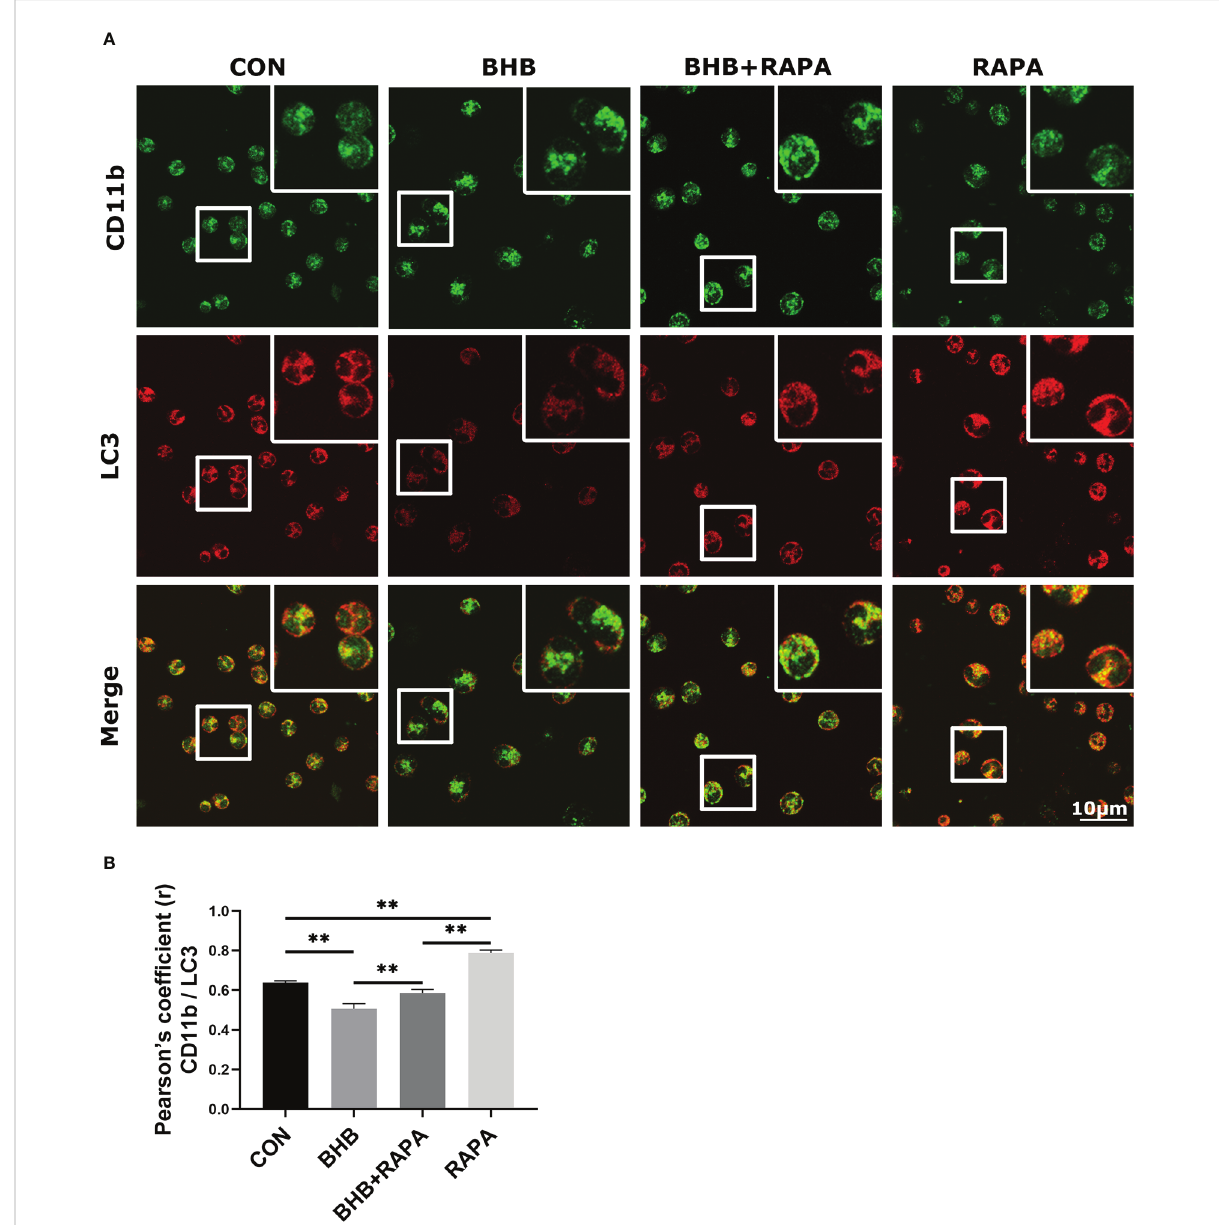
FIGURE 5 Role of autophagy in BHB induced depression of co-localization between CD11b and LC3. Rapamycin (100 n M , 2 h ) was used to activate autophagy. (A) Immuno fl uorescence data showed the co-localization of CD11b with LC3 in neutrophils. Magni fi cation 400×. Scale bar = 10 m m. Nuclei/DAPI in blue, CD11b in green, and LC3 in red. Images here represent the typical common phenotype of each group. (B) Pearson ’ s correlation coef fi cient (r) between CD11b and LC3. Data were expressed as the mean ± SEM. A two-way analysis of variance (ANOVA) was performed to analyze differences between BHB and RARA, including a Bonferroni post-hoc analysis. Two-way ANOVA showed a signi fi cant difference in BHB × RAPA interaction ( P < 0.01), including a Bonferroni post-hoc analysis. ** P < 0.01 as statistically highly signi fi cant. CON, control; BHB, b -hydroxybutyrate; RAPA, rapamycin; LC3, microtubule associated proteins 1A/1B light chain 3; CD11b, integrin alpha-M precursor; SEM, standard error of the